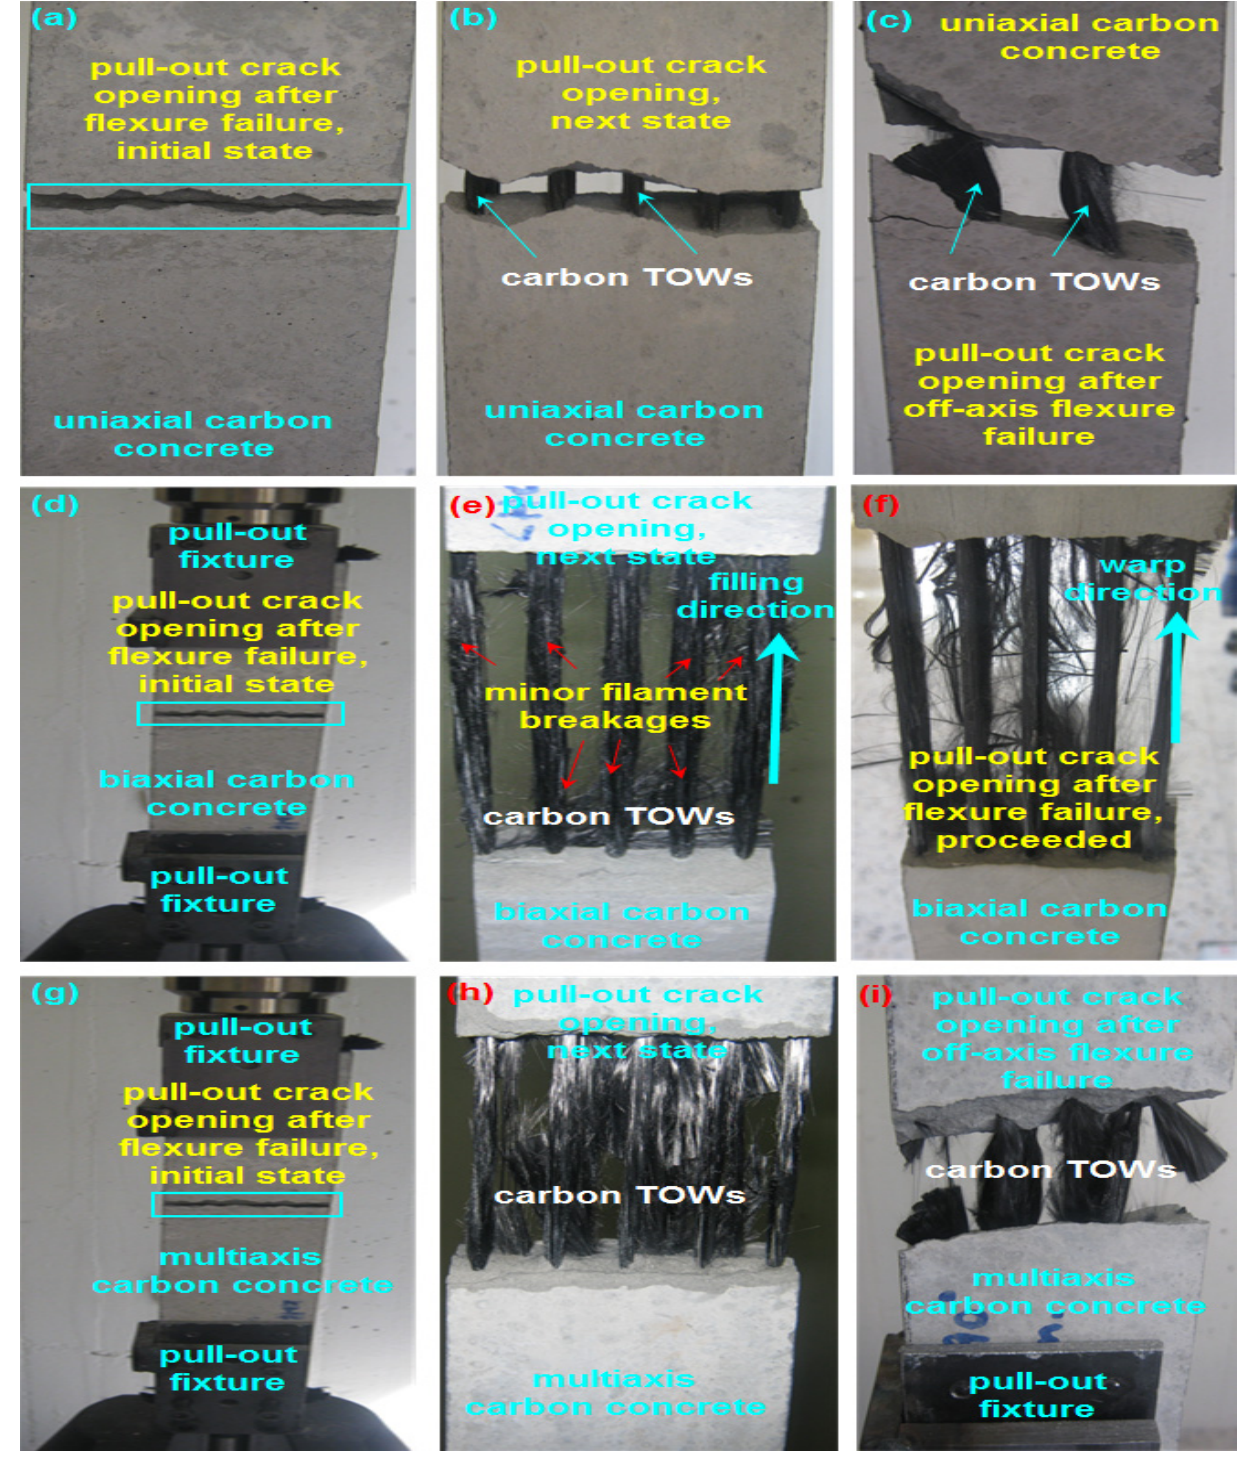
Figure 21. Pull-out of multiaxis 3D carbon fiber concretes. ( a ) Initial state of pull-out crack opening after flexural failure (C-1D); ( b ) next state of pull-out crack opening (C-1D); ( c ) pull-out crack opening after off-axis flexural failure (C-1D); ( d ) initial state of pull-out crack opening after flexural failure in filling (C-2D); ( e ) next step of pull-out crack opening in filling (C-2D); ( f ) warp direction pull-out crack opening after flexural failure, proceeded (C-2D); ( g ) initial state of pull-out crack opening after flexural failure in filling (C-4D); ( h ) next state of pull-out crack opening in filling (C-4D) and ( i ) pull-out crack opening after off-axis flexural failure in the warp (C-4D).